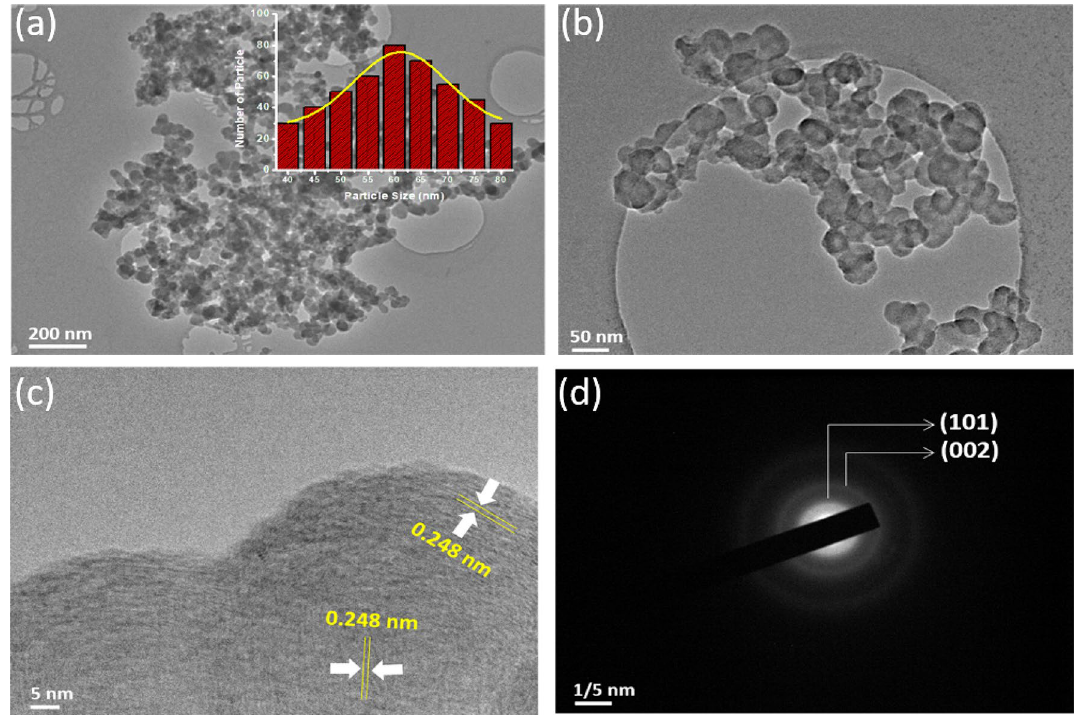
Figure 3. ( a ) and ( b ) TEM bright field images of synthesized CNPs at different magnification (inset: corresponding particle size histogram), respectively, ( c ) HRTEM image of single CNP nanoparticle, ( d ) SAED pattern of CNP.